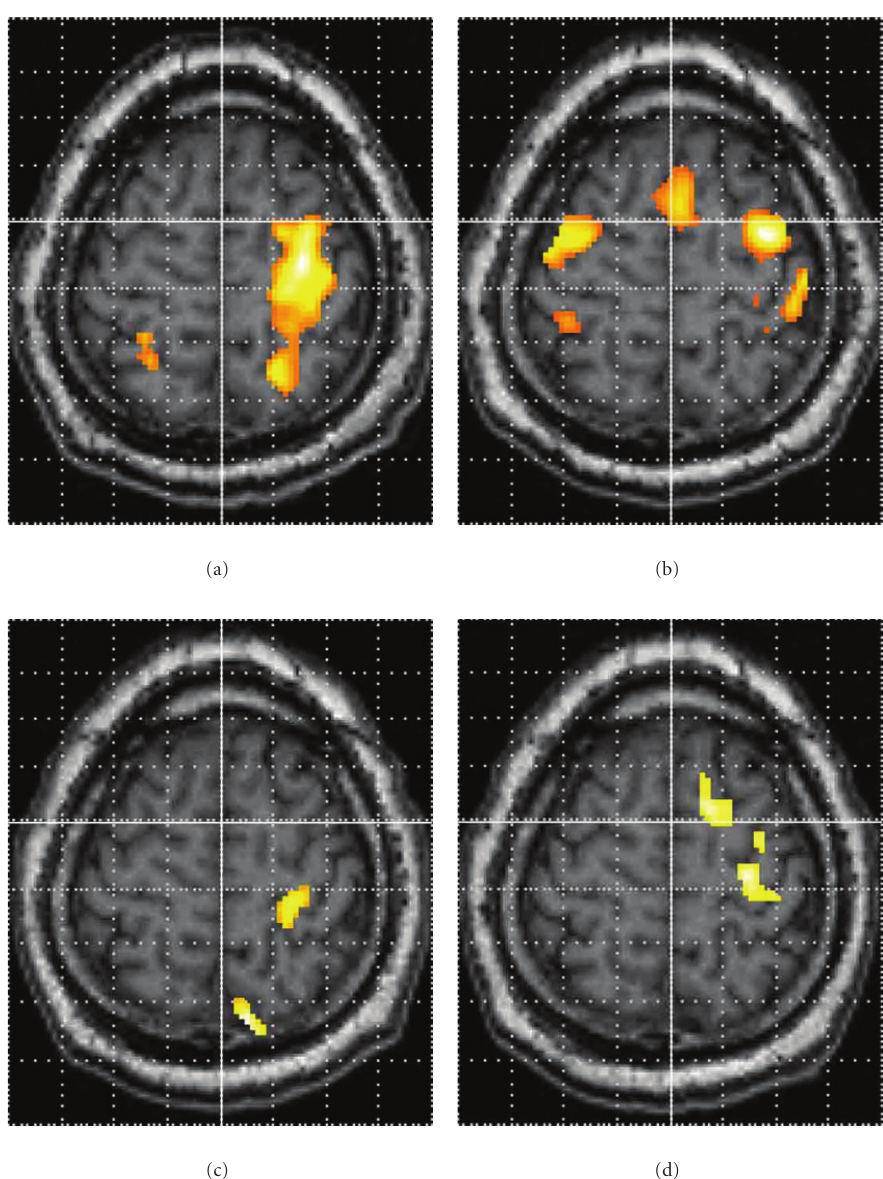
Figure 6: Serial fMRI results of a 34-year-old male with left BPI during the motor task of the a ff ected elbow. (a) The first fMRI (before operation), (b) the second fMRI (approximately 1 year after operation), (c) the third fMRI (approximately 2 years after operation), and (d) the fourth fMRI (approximately 3 years after operation). The patients’ right is on the observers’